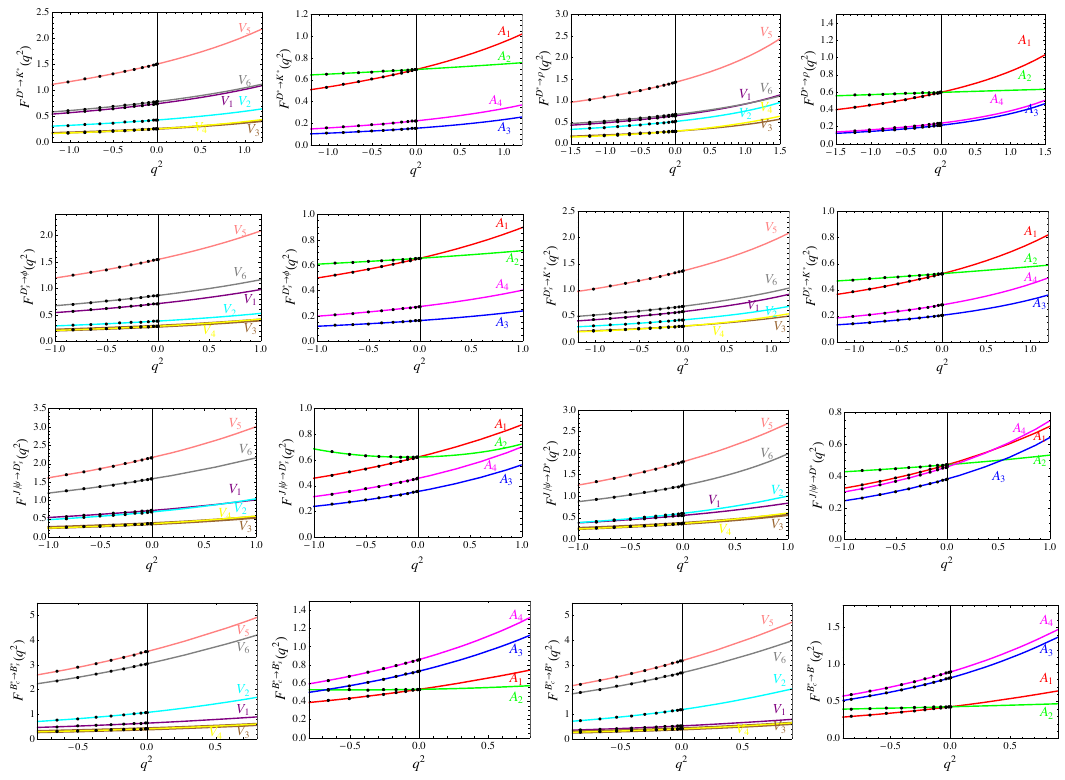
Figure 5 . Same as (cid:12)gure 3 except with the parameterization scheme given by eq. (4.15).